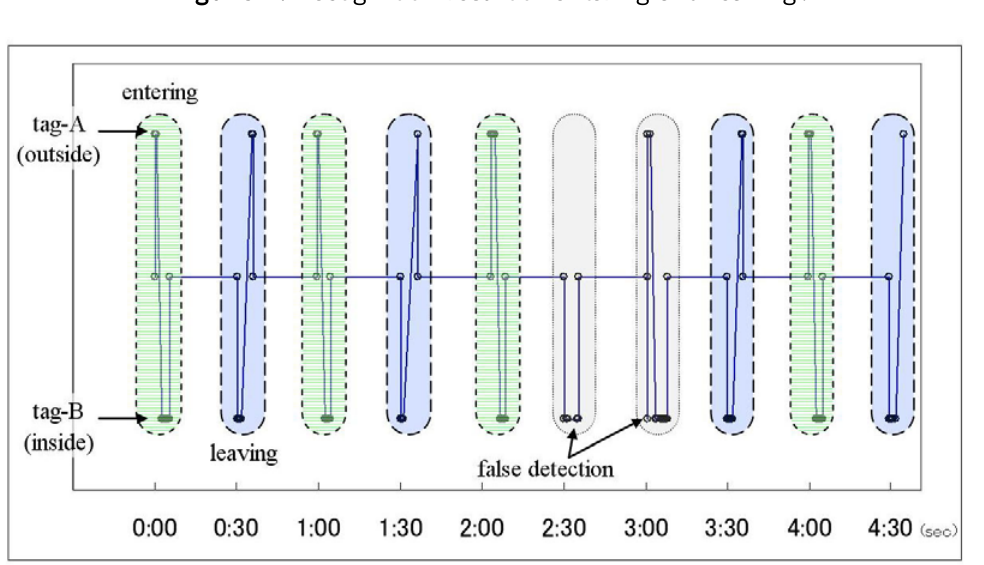
Figure 7. Recognition result of entering and